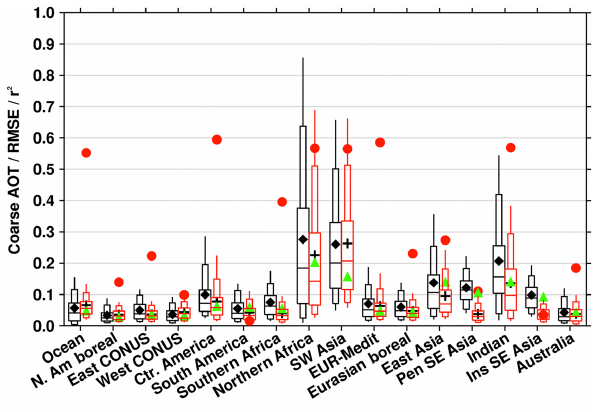
Figure 9. Cumulative distribution function for the reanalysis 6- hourly AOT errors compared to AERONET L2, MODIS and MISR data assimilation-quality data with respect to the available total, fine and coarse modes at 550nm for the entire reanalysis time period (2003–2013).